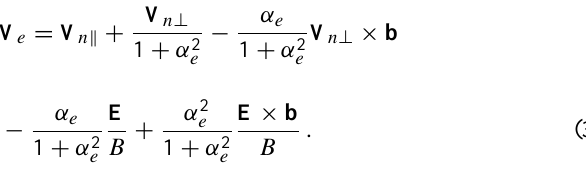
an electric field such that the resulting ion Pedersen current would produce an ion motion equal and opposite to the mo- tion produced by the neutral